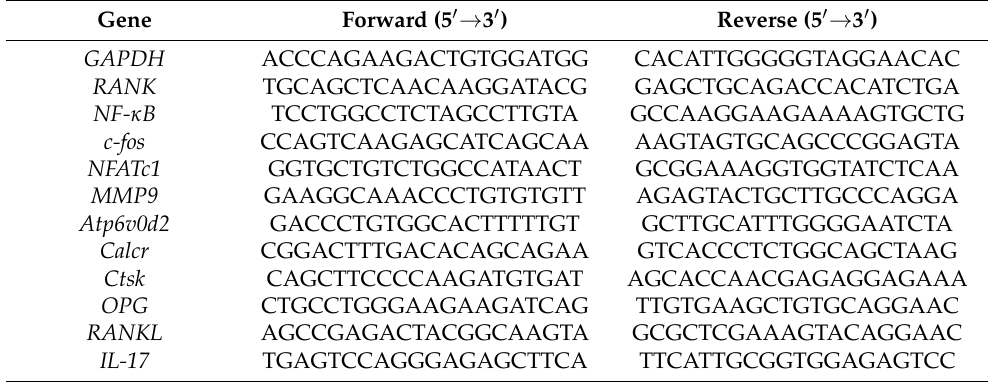
Table 1. Primer sequences used for